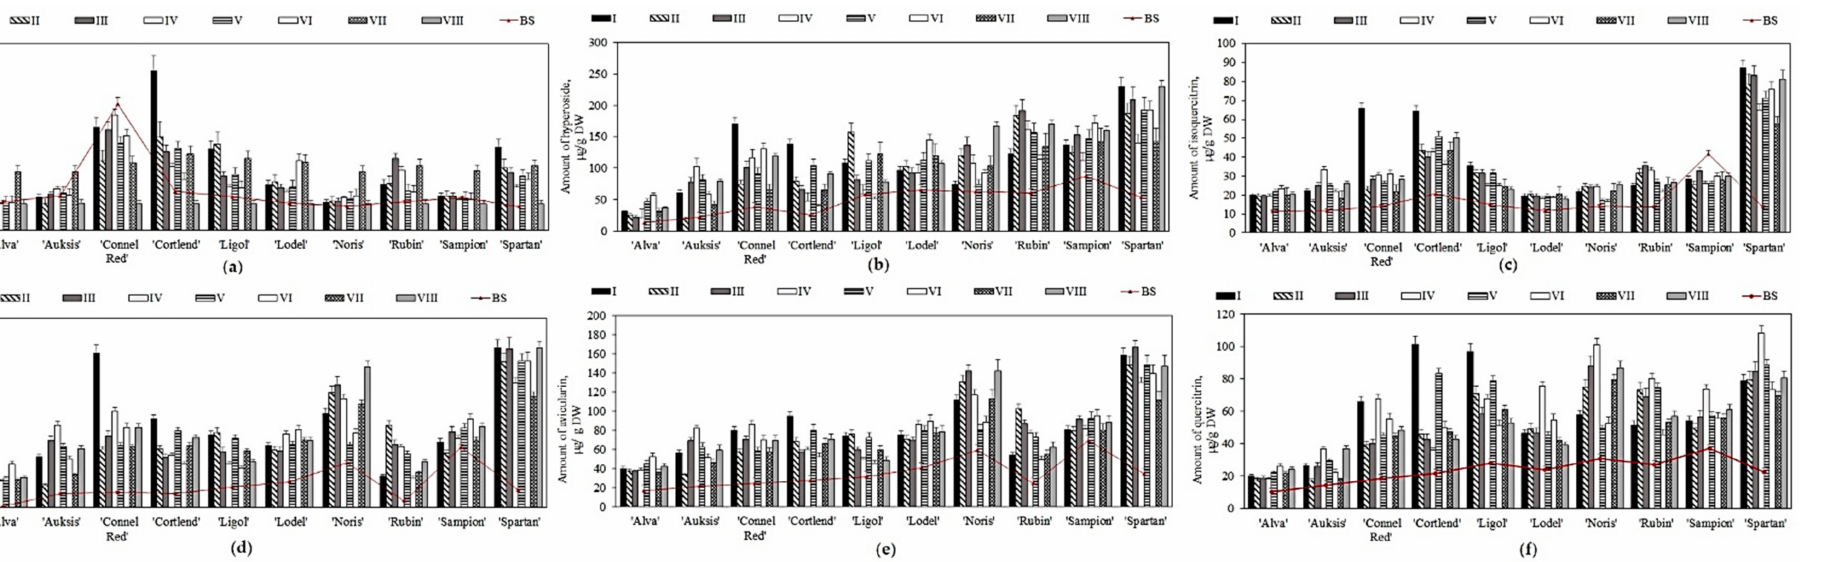
Figure 4. Changes in the amount of flavonols in whole apple samples before and after storage in controlled atmosphere: ( a ) Changes in the amount of rutin; ( b ) Changes in the amount of hyperoside; ( c ) Changes in the amount of isoquercitrin; ( d ) Changes in the amount of reynoutrin; ( e ) Changes in the amount of avicularin; ( f ) Changes in the amount of